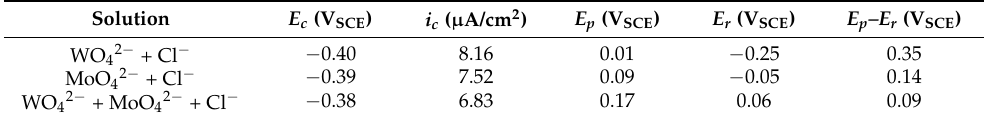
Table 2. Calculated values of E c , i c , E p , E r and ( E p – E r ) for Q235 carbon steel in WO 4 2− + Cl − , MoO 4 2− + Cl − and WO 4 2− + MoO 4 2− + Cl − solutions.